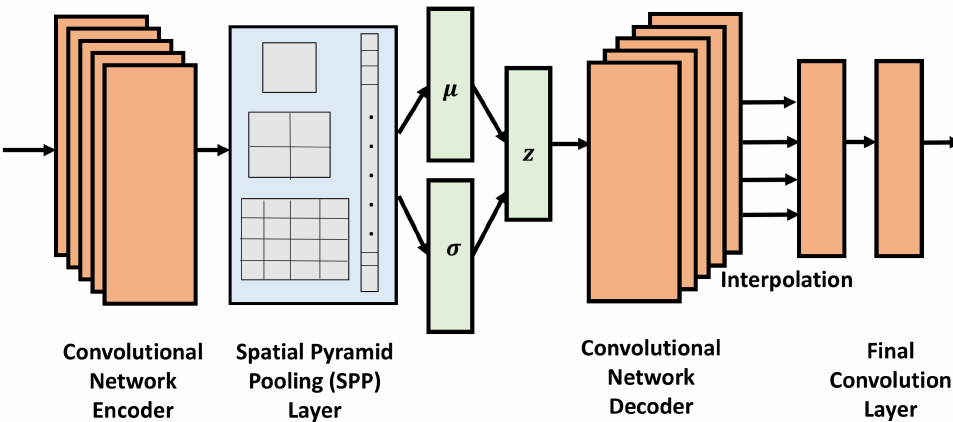
Figure 1. The key components of the proposed CVAE-SPP network are depicted in the schematic. Convolutional layers are used in both the encoder and decoder of the network, allowing it to learn patterns over distance matrices. A SPP layer enables the encoder to accommodate distance matrices of various sizes. Another proposed β CVAE-SPP network utilizes the same schematic but adds an extra hyperparameter denoted by β in order to regulate the loss